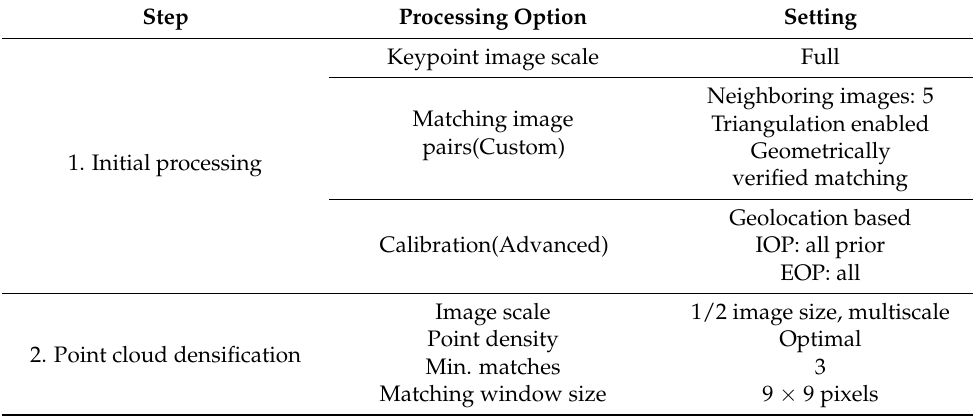
Table 2. Processing settings in Pix4Dmapper selected for all UAV-SfM